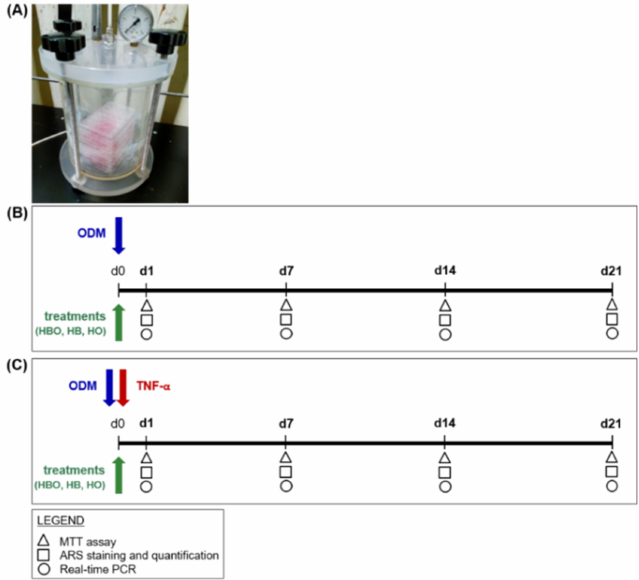
Figure 8. Schematic experimental design of treatments starting simultaneously with the osteogenic di ff erentiation of hADSCs. ( A ) Image of hyperbaric culture chamber used for HBO exposures.